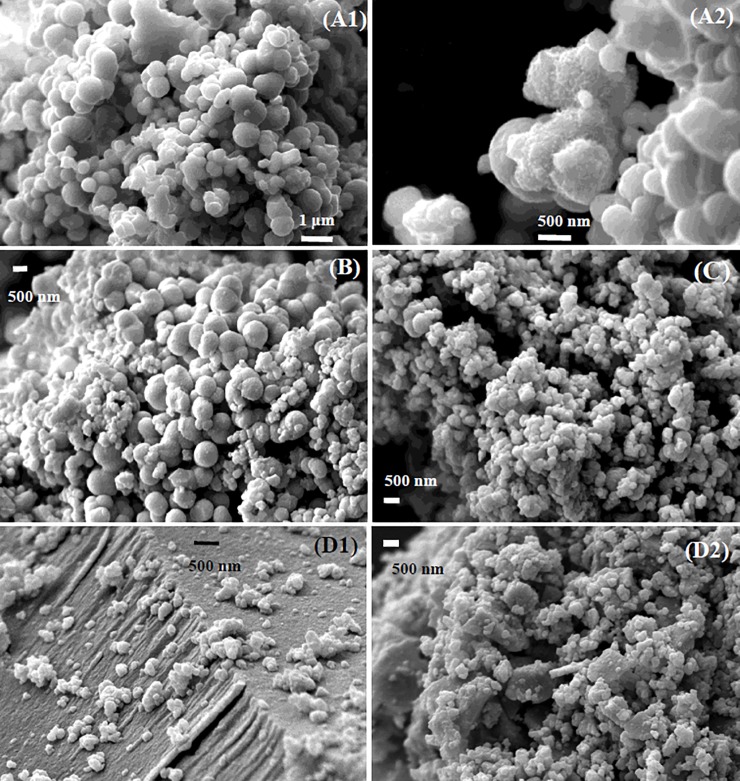
Scanning electron micrographs (SEM) of zero Cr(III)- and Cr(III)-incorporated schwertmannite.(A1, A2) zero Cr(III)- schwertmannite with large spheroids; (B) low; (C) medium and, (D1 and D2) high Cr(III)- incorporated schwertmannite.